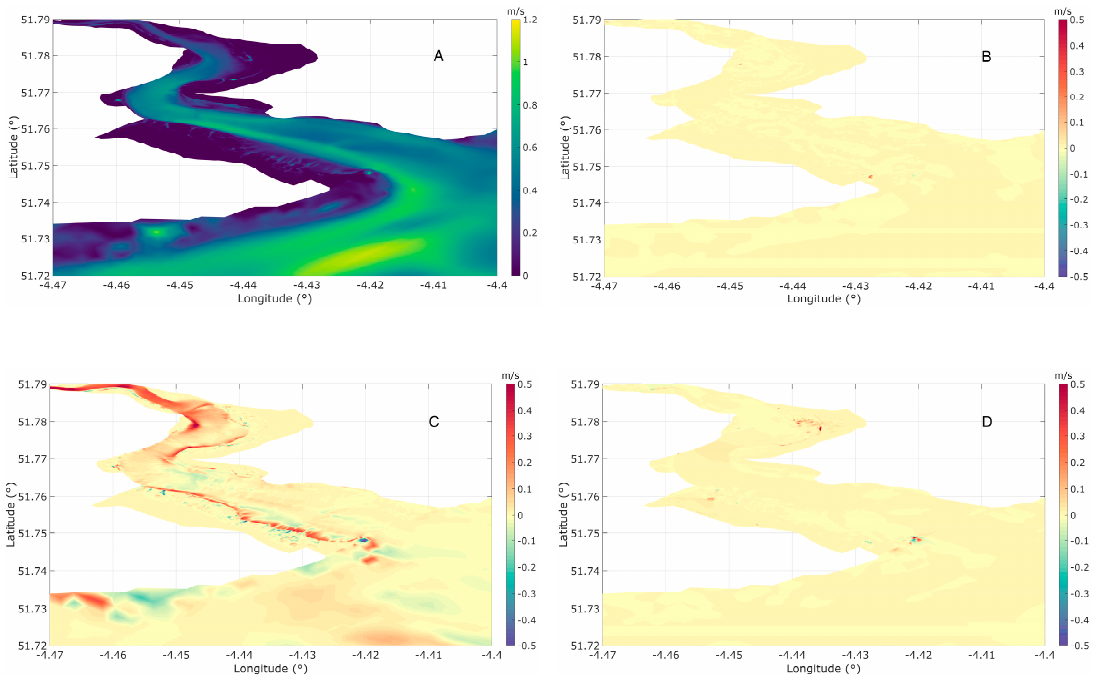
Figure 17. Comparison of peak flood current magnitude during the 1:50 year easterly storm. ( a ) Current condition, ( b ) difference between defended and current condition, ( c ) difference between grazed and current condition, and ( d ) difference between managed realignment and current condition. Figure 18. Comparison of peak ebb current magnitude during the 1:50 year easterly storm. ( a ) Current condition, ( b ) difference between defended and current condition, ( c ) difference between grazed and current condition, and ( d ) difference between managed realignment and current